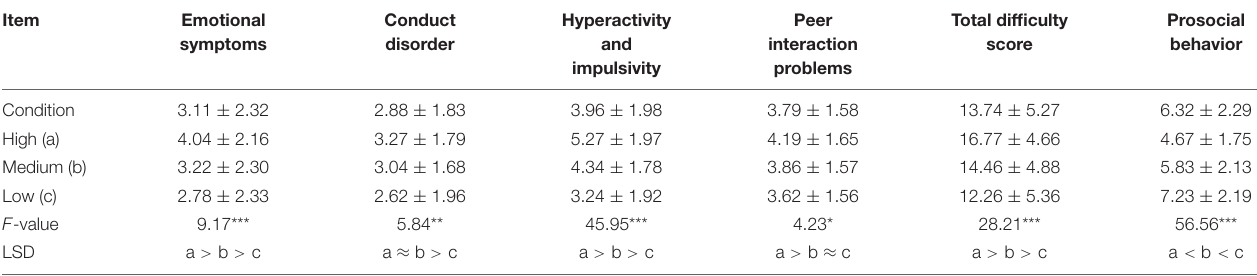
TABLE 3 | Comparison among the different latent classes of psychological capital in terms of characteristics and differences regarding emotional and behavioral problems. Item